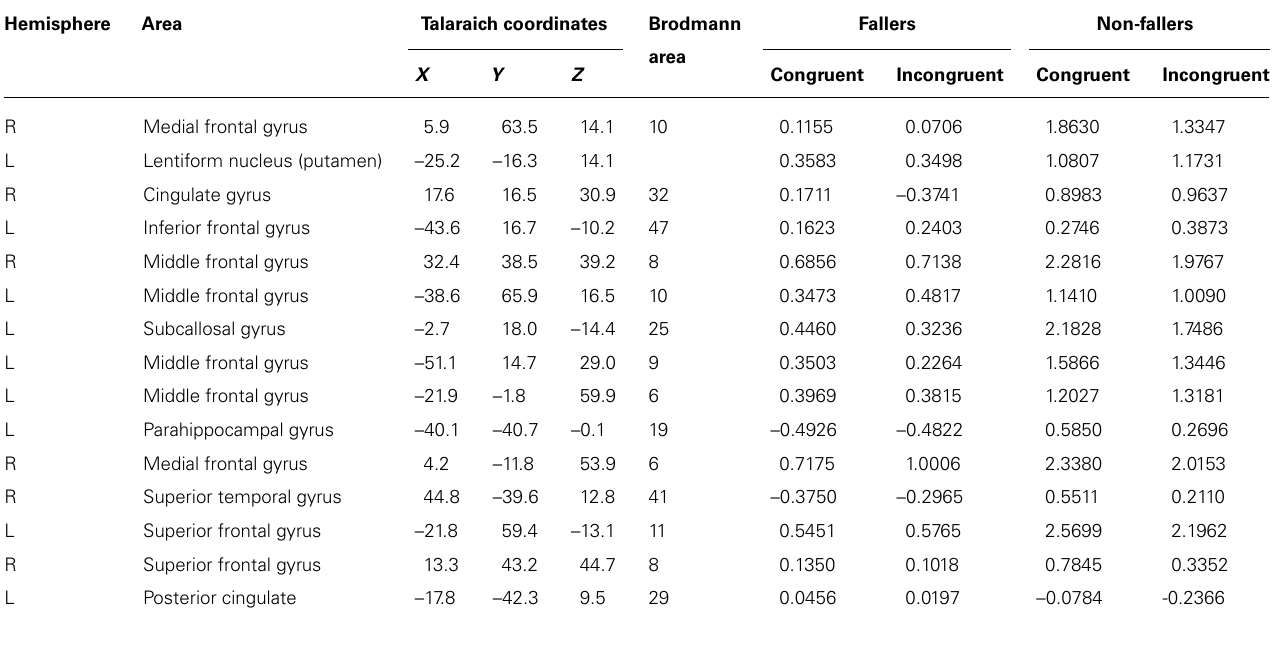
Table 2 | Regions of interest and percent signal change for the significant group by condition